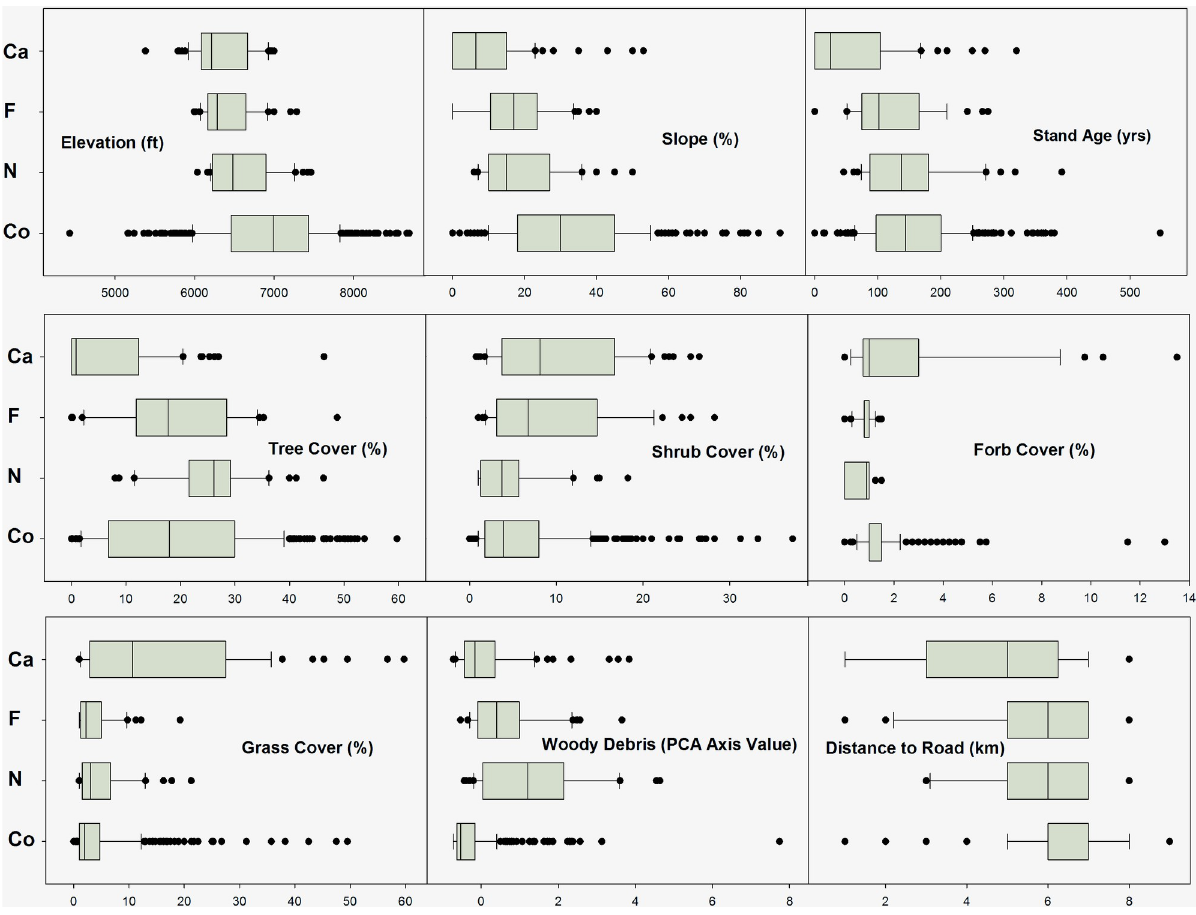
Fig 5. Box plots for analyzed habitat attributes. Box plots for continuous attributes used in logistic regression models, as described in Table 2. The median and lower quartile are visually indistinguishable in the Distance to Road attribute for control sites. Y-axis codes are Co = control sites, N = Pinyon Jay nesting locations, F = Pinyon Jay foraging locations, and Ca = Pinyon Jay caching locations. For better visual clarity, the extreme high range of observed Forb Cover values (15–25%) is truncated, omitting a small number of outlier Co sites and Ca locations.